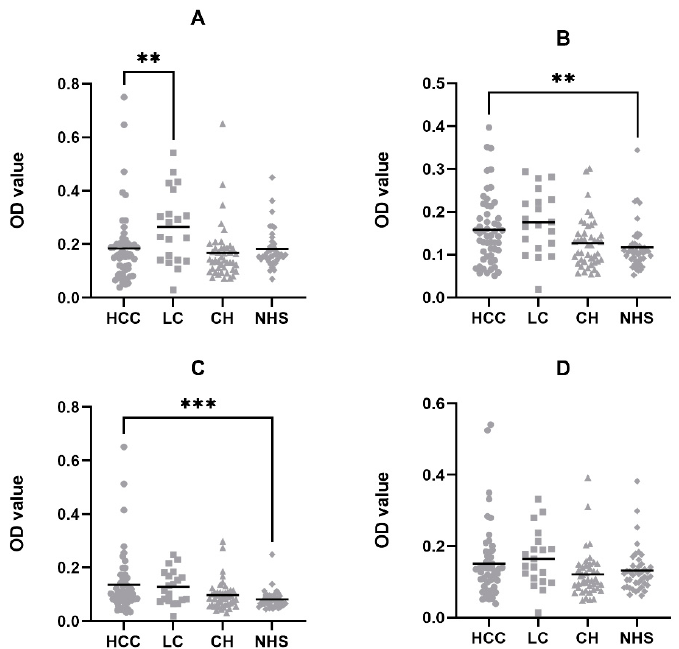
Figure 3. Autoantibody titers of the four TAAs in the Asian sera cohort by ELISA. The autoantibody titers were compared between the Asian HCC group with the LC, CH, and NHS sera groups. Mann– Whitney tests show significant differences in anti-p16 and HSPA5 autoantibodies when comparing the Asian HCC group with the NHS control group. ( A ) DNMT3A; ( B ) p16; ( C ) HSPA5; ( D ) HSP60. HCC: Hepatocellular carcinoma; LC: Liver Cirrhosis; CH: Chronic Hepatitis; NHS: Normal Healthy Sera. ** p < 0.01, *** p < 0.001.